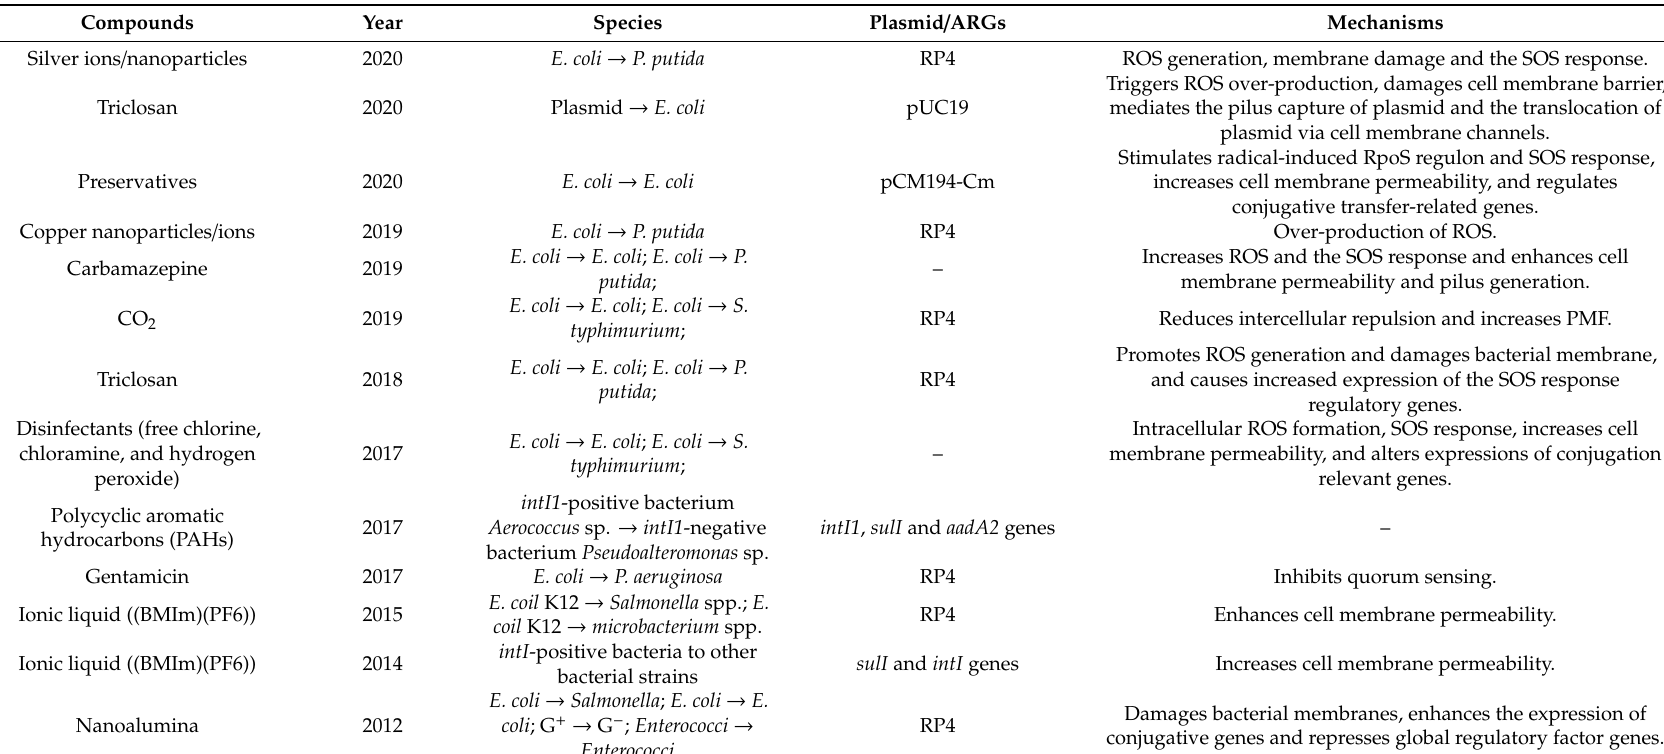
Table 1. Exogenous compounds that promote horizontal transfer of antibiotic resistance genes